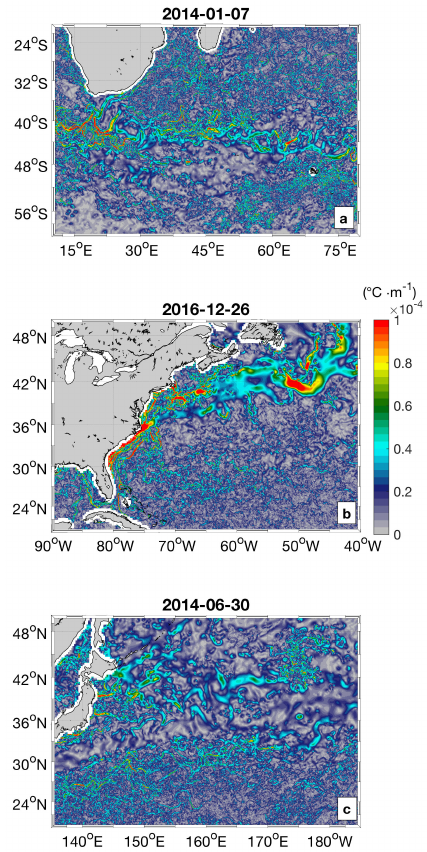
Figure 6. ( a ) |∇ SST | in the Agulhas Current area; ( b ) same, in the Gulf Stream area; ( c ) same, in the Kuroshio Current area. The images correspond to the |∇ SST | based on MUR SST on three different dates indicated in the